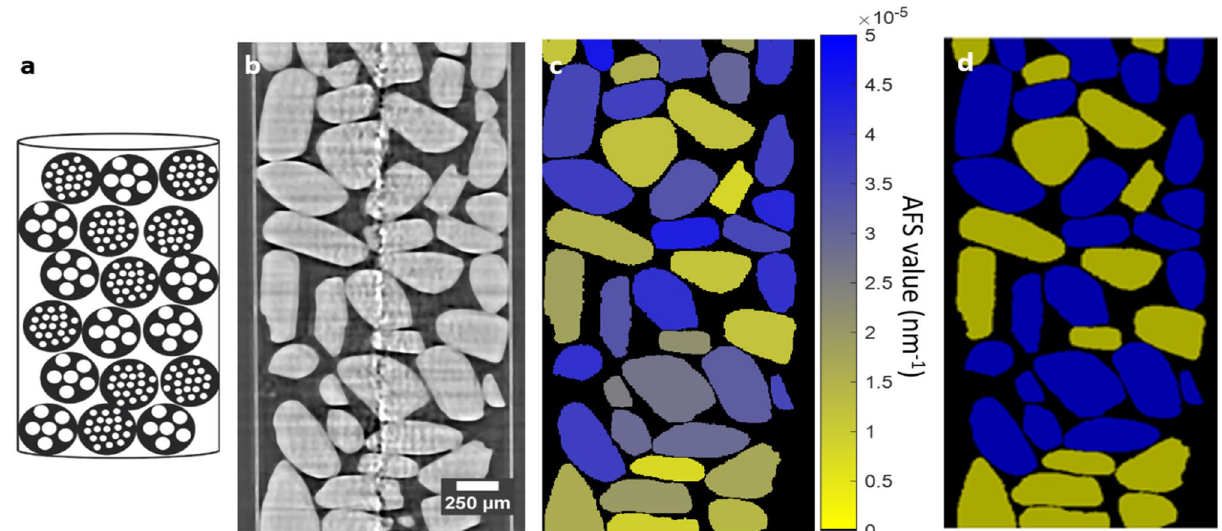
Figure 5. A schematic representation of the sampled with mixed particles ( a ). In ( b ) a vertical cross section through the absorption dataset is given, the vertical line in the center is due to ring artifacts. The proposed procedure derives an AFS value per segmented particle ( c ). These AFS values are then clustered to classify the 150 nm particles (yellow) from the 50 nm particles (blue) ( d